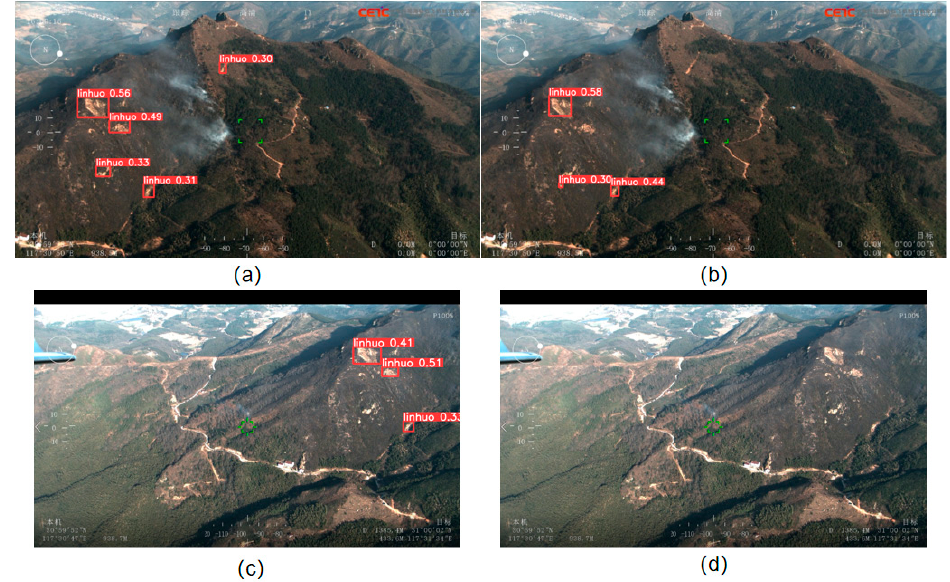
Figure 12. Comparison of YOLOv5s and our model. Our model suffers less interference. ( a ) Five detection errors detected by YOLOv5s. ( b ) Three detection errors detected by our model. ( c ) Three detection errors detected by YOLOv5s. ( d ) No error detections detected by our model.